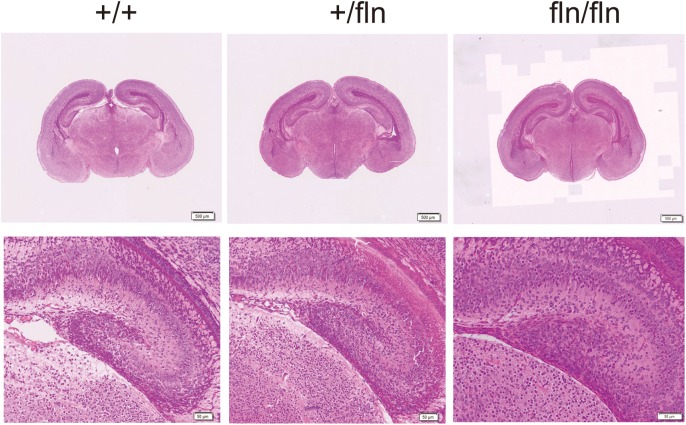
No obvious histological abnormality was detected in homozygous. Representative sections of H&E staining on hippocampus samples from +/+ (n = 3), +/fln (n = 3), and fln/fln (n = 3) embryos at E18.5. Bar = 500 μm at low magnification, Bar = 50 μm at higher magnification.